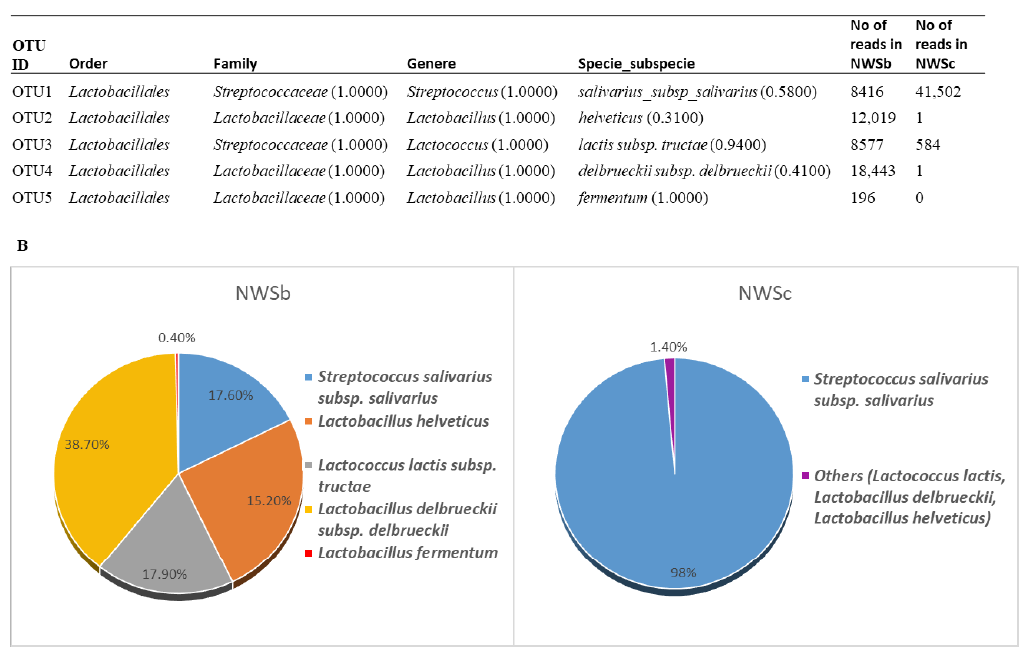
Figure 2. Metagenomic analysis of NWSs. ( A ). Taxonomic identification of OTUs and number of reads analyzed for each of them. Values in parentheses indicate statistical confidence of each taxonomic assignment, between 0 and 1 (with 1 higher reliability and 0.8 standard cut off). ( B ). Graphic representation of relative abundance of taxonomic units, based on the number of reads reported in panel A.